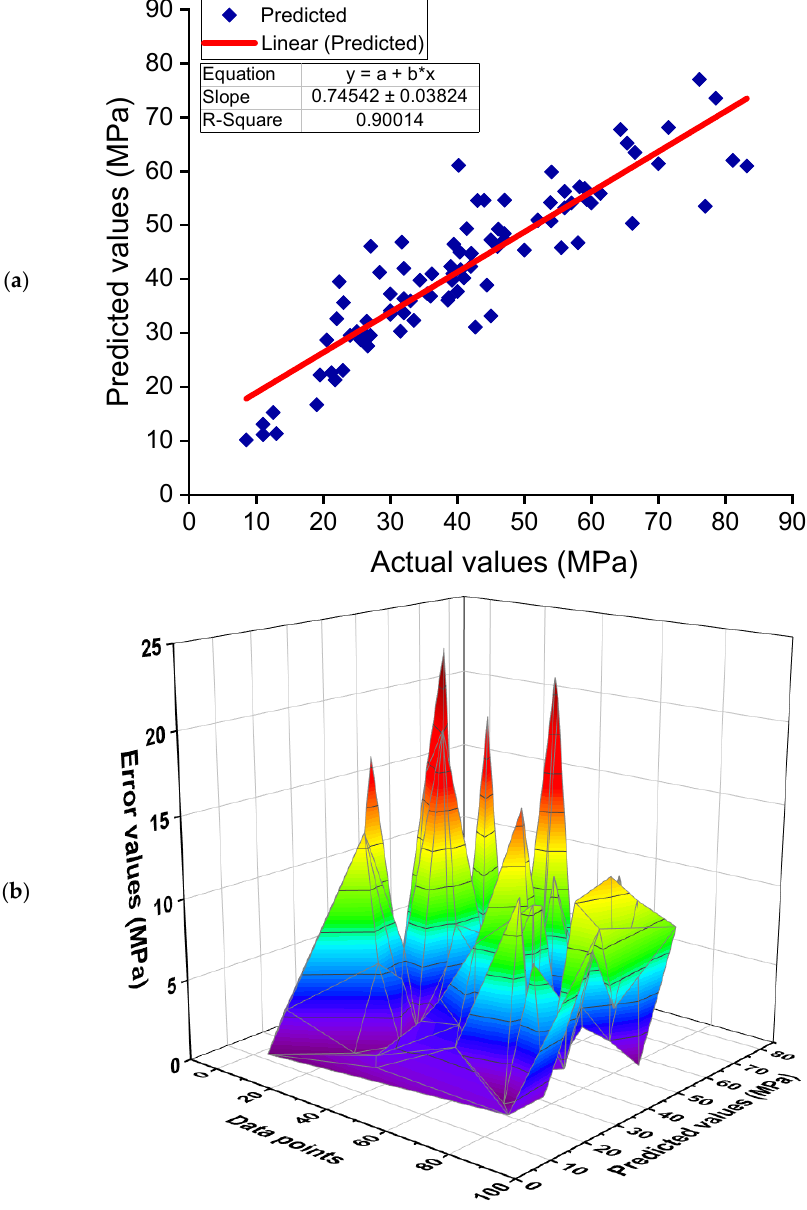
Figure 9. Random forest model: ( a ) correlation between experimental and estimated results; ( b ) dispersal of predicted and error values.